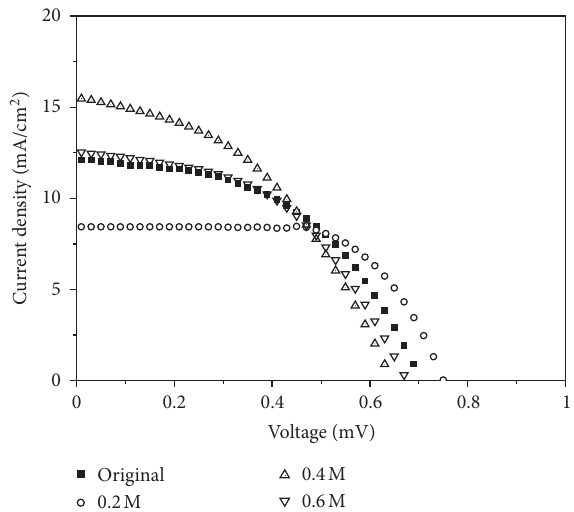
Gel polymer electrolyte + ionic liquid F 8: Variation of conversion efficiency over time for the DSSCs composed of a liquid-type electrolyte, a gel-electrolyte and a gel-electrolyte containing 0.4M 1-butyl-3-methyl-imidazolium